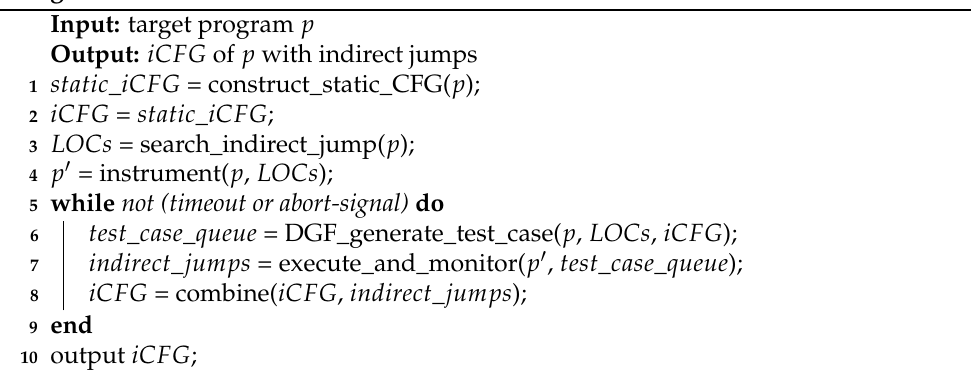
Algorithm 1: The workflow of DGF-based CFG